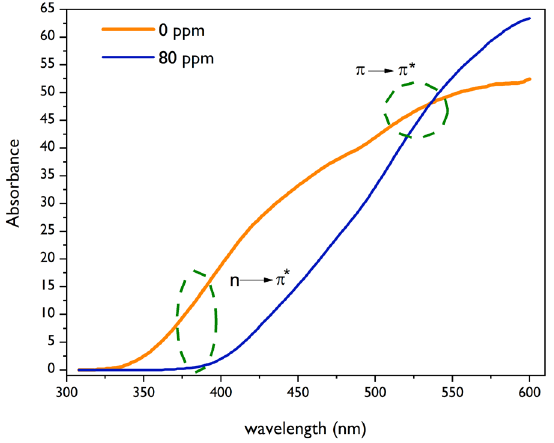
Figure 3. The UV-Vis spectroscopy result of the inhibitor solution.